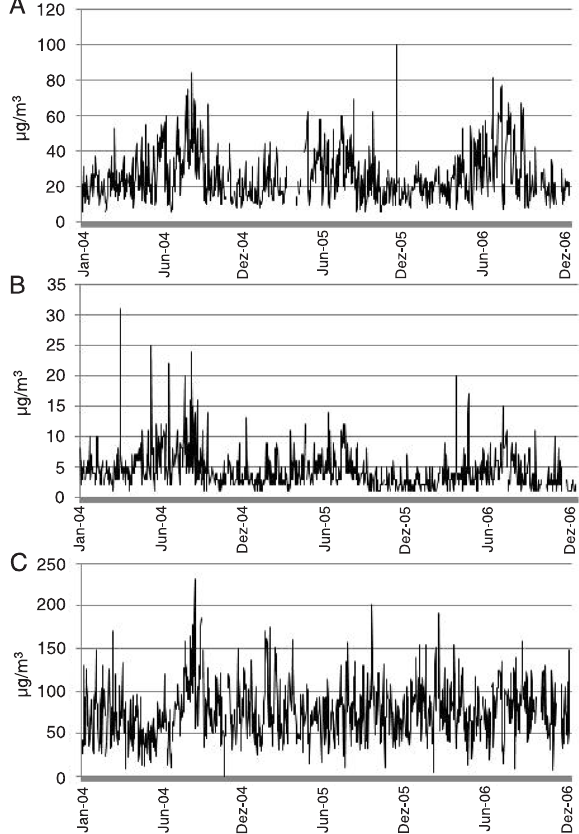
Figure 1. Daily values of pollutant particulate matter (A), sulfur dioxide (B), and ozone (C) during the study period, São José dos Campos, Brazil, 2004-2006. (Source: São Paulo State Sanitary Agency).